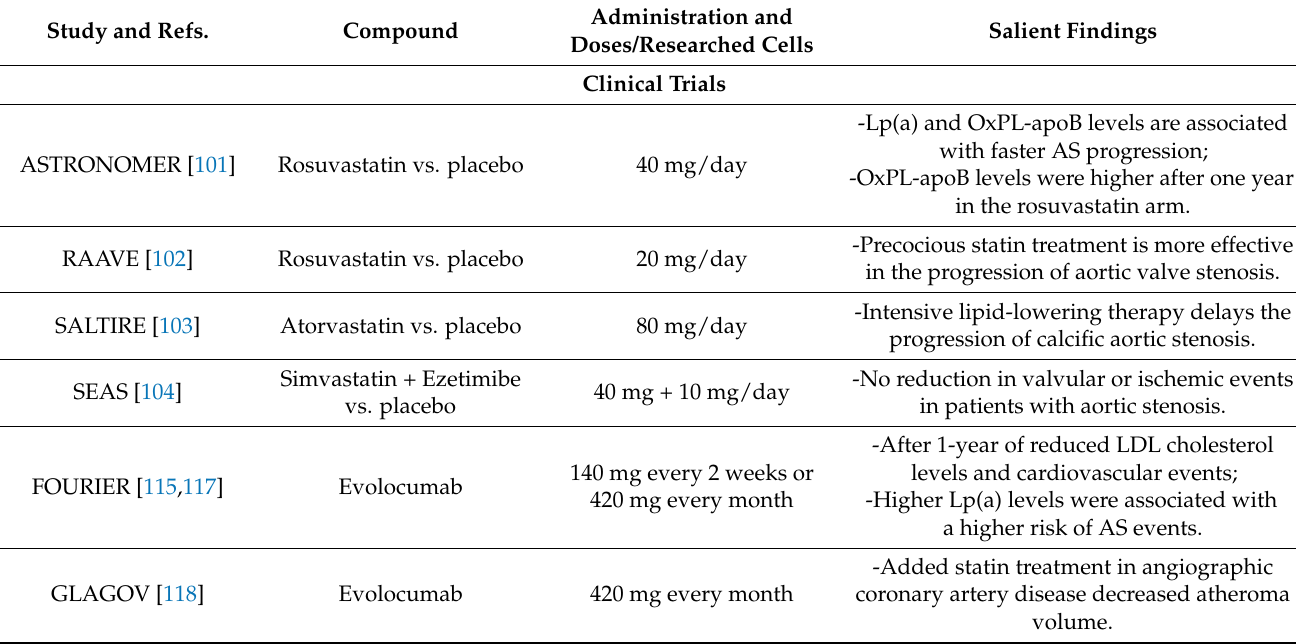
Table 1. Human trials of therapeutic strategies via OS in